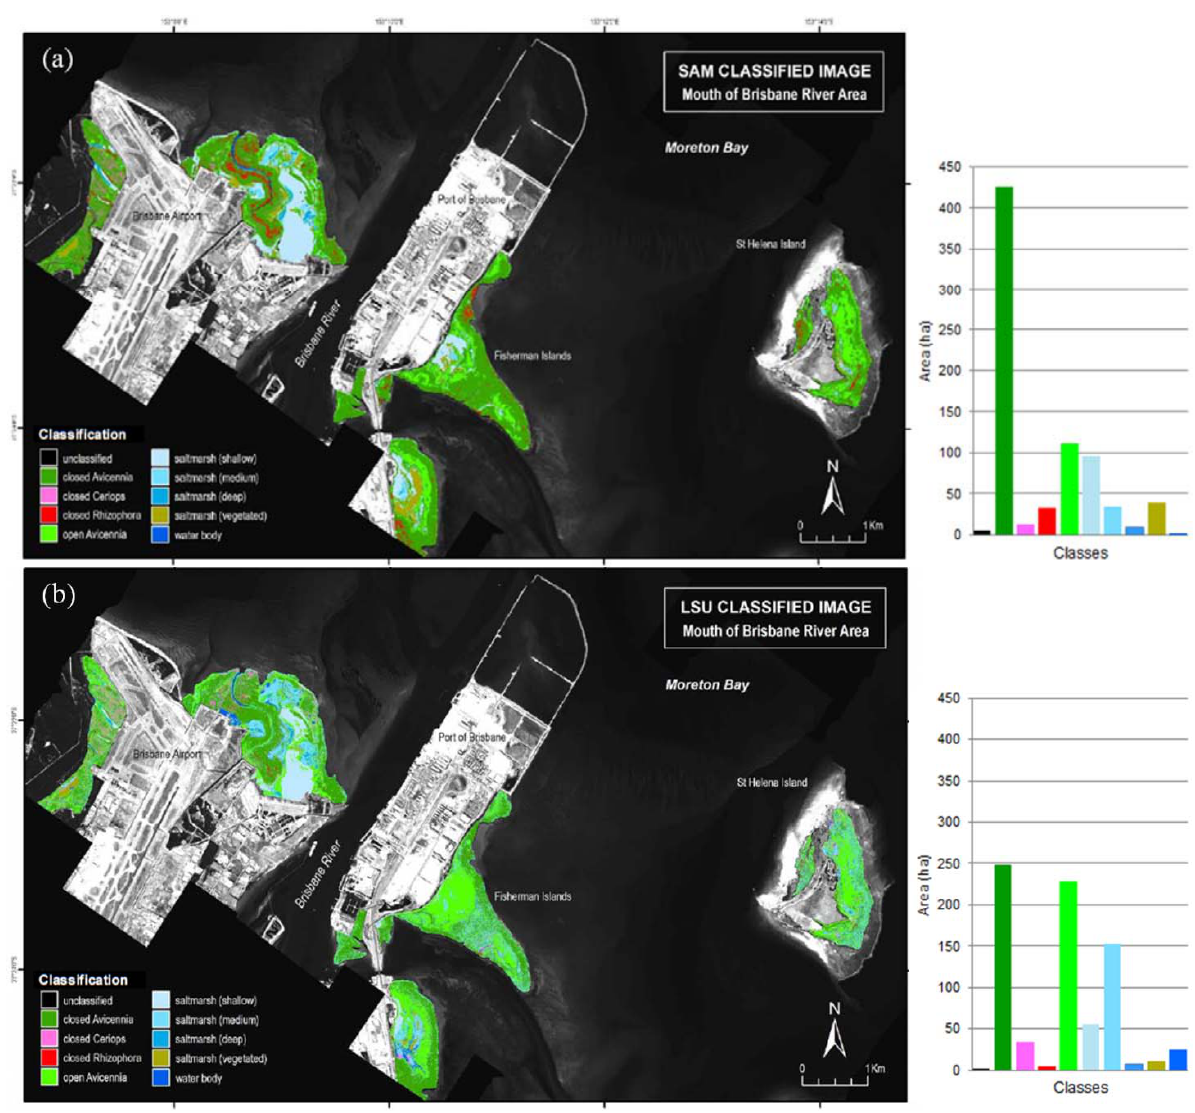
Figure 11. Maps of wetland classes and their area in hectares: (a) spectral angle mapper (SAM); (b) linear spectral unmixing (LSU); and (c) object-based approach. Background image is near infrared band of CASI-2 (band 29, centred at 799